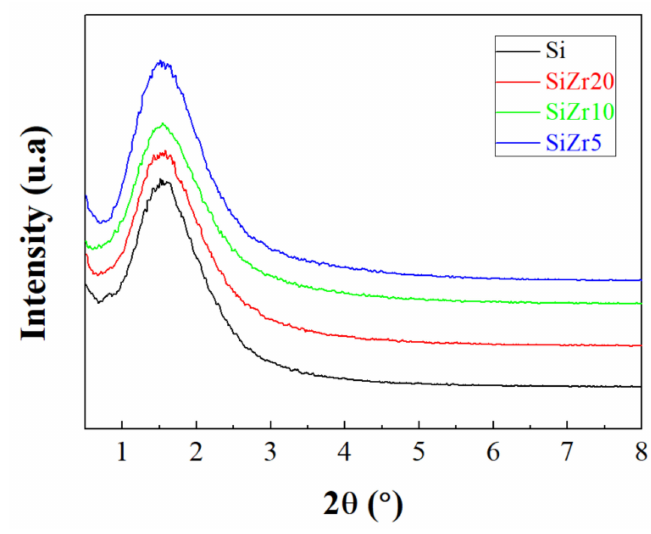
Figure 1. X-ray diffractograms of Si, SiZr20, SiZr10 and SiZr5 samples. To determinate morphology of the porous silica modified with pore expander agents, transmission electron microscopy was carried out (Figure 2). Figure 2A shows that the traditional SBA-15 displays a honeycomb structure. The modification of this structure with fluoride species and TMB as a pore expander agent (Figure 2B) causes a strong modification of the structure, obtaining a less-ordered porous structure, with shorter channels and higher pore diameter. The incorporation of the Zr-species in the synthetic step (Figure 2C–E) seems to increase the disorder of the porous structure leading to poorer defined porous structures.